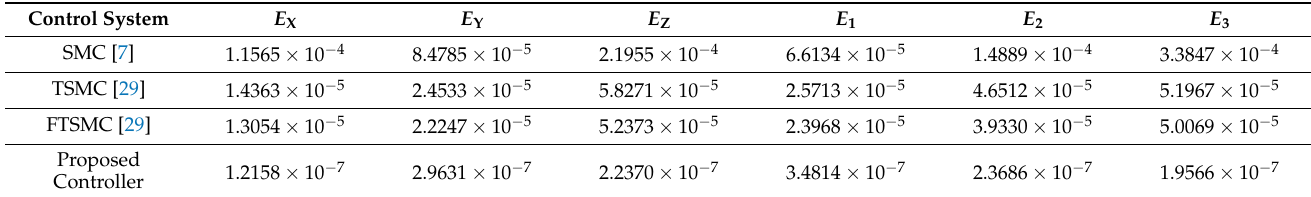
Table 5. RMSEs via four Control Strategies.